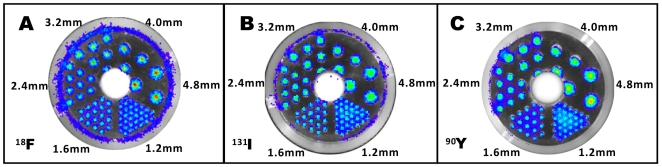
Phantom imaging studies with radioactive OI and PET.(A–C) Radioactive OI of 18F, 131I and 90Y phantoms.